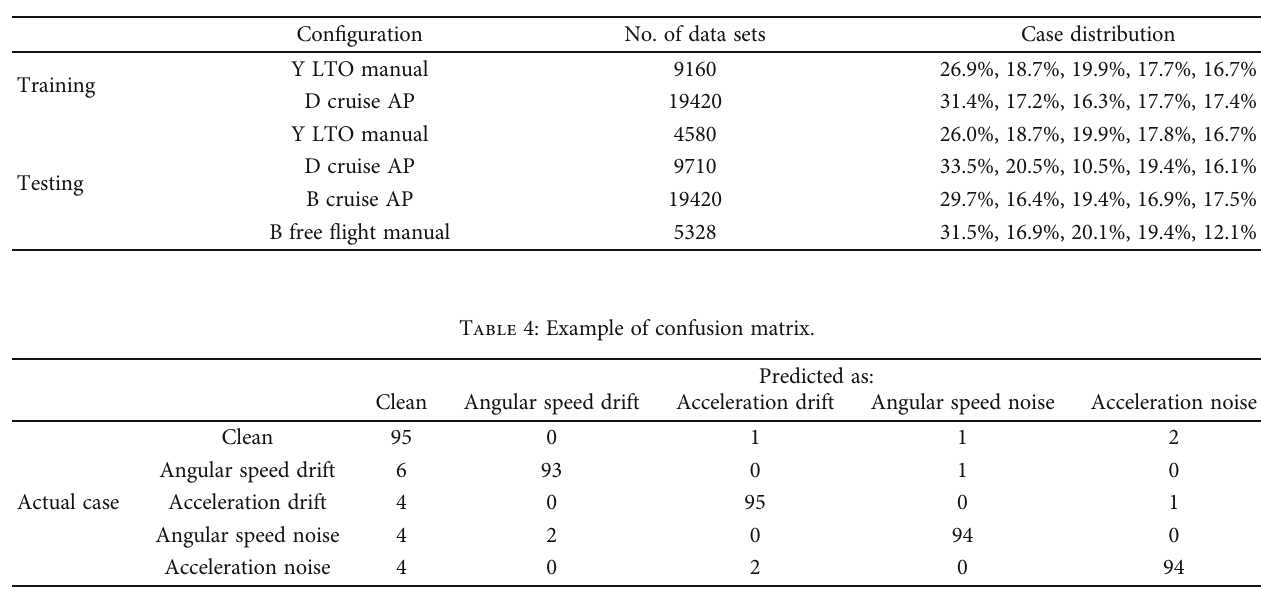
Figure 3: Formation of fl ight data Table 3: Data sets for DNN training and testing.